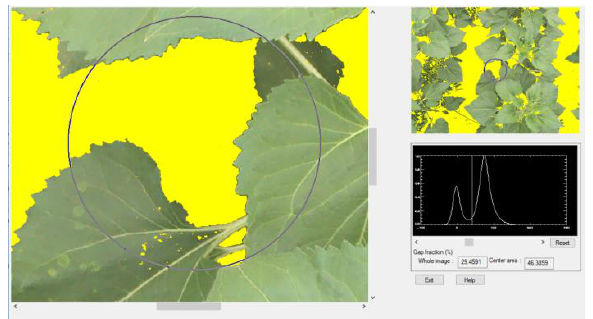
Figure 3. Digital camera images of 2014-23, sunflower plant image is classified by Green Crop Trcaker software. Green Crop Tracker automatically derives estimates of green crop fraction. This software uses a histogram-based threshold method to estimate crop cover fraction.